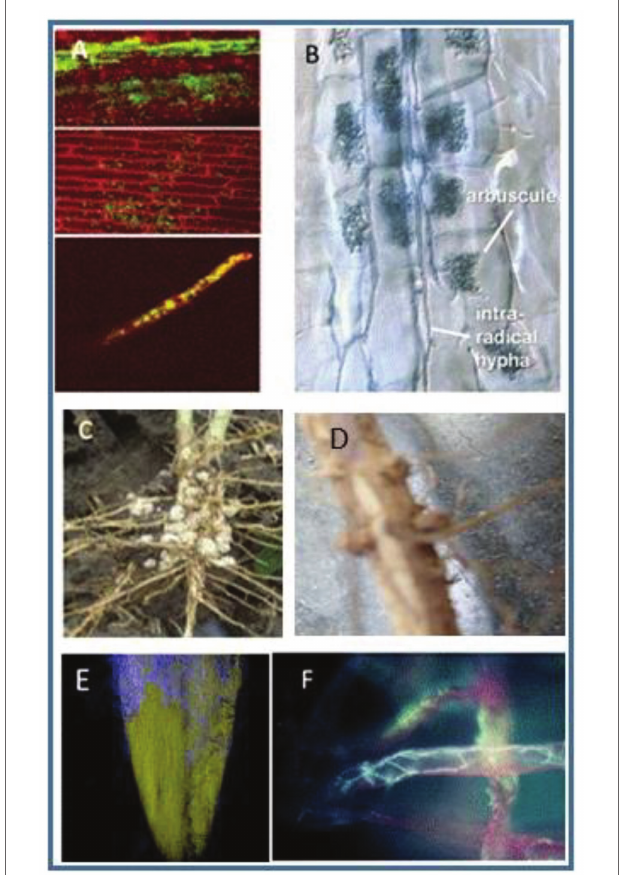
FIGURE 1 | Examples of endophytic colonization by different bacteria or fungi. (A) Endophytic colonization of rice by Rhizobium leguminosarum bv. Trifoli in rice. The photomicrograph shows the bacteria in the stems after the bacterium was applied to seeds. From (Chi et al., 2005). The journal does not require persmission to use materials. (B) Photograph of mycorhizzae labeled to show arbucules and hyphae within roots, from (Schussler, 2009), used with permission of the author. (C) Nodules on soybean roots. Used courtesy of Advanced Biological Marketing. (D) Photograph of nodules on soybean roots. Photo by the first author. (E) A photomicrograph of fluorescent imaging of a corn root showing growth of Trichoderma on the surface. Spores of the fungus were added to seeds, and the growth shown was taken 2 days later. Photograph courtesy of Advanced Biological Marketing. (F) Fluorescent photomicrograph of Trichoderma growing in root hairs. From (Harman et al., 2004a), used with permission of the